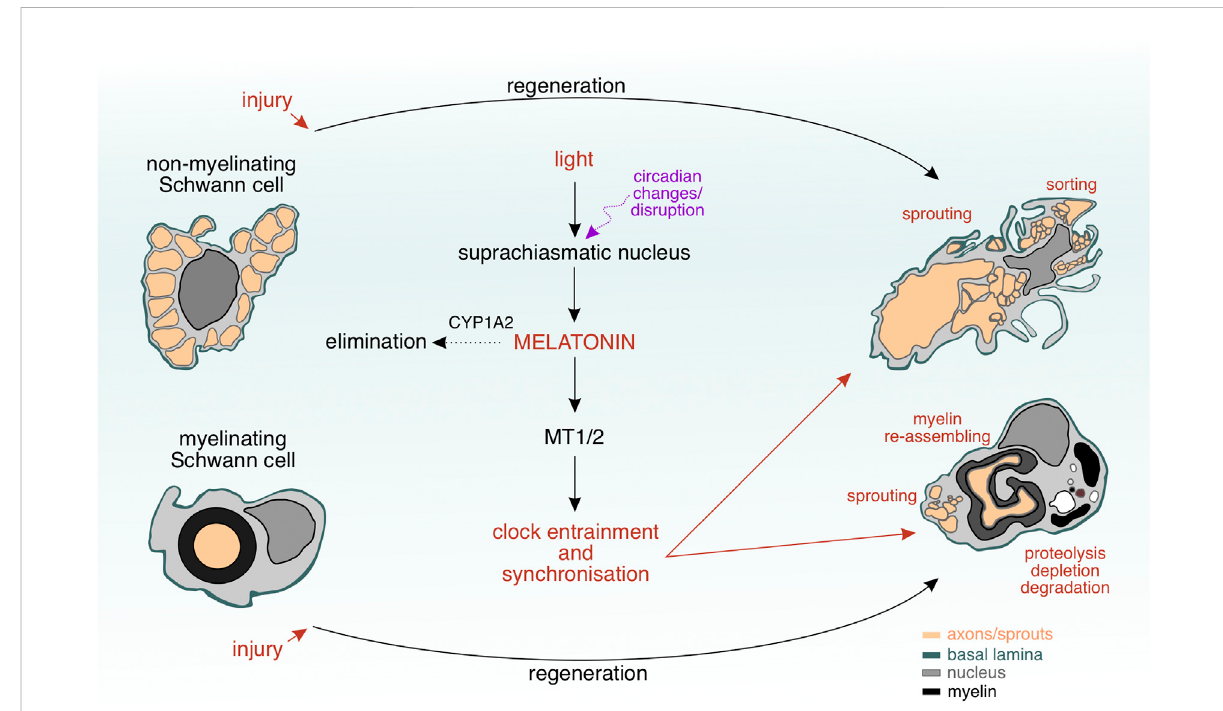
FIGURE 5 Interplay between Schwann cell plasticity and circadian clock during nerve regeneration. The Schwann cells undergo a remarkable transformation during nerve regeneration upon injury. Variations inlight ’ s intensity due to circadian changes ordisruption result inan altered activity of the suprachiasmatic nucles and melatonin concentration levels, to which the Schwann cells can respond selectively via their melatonin receptors (MT1/2). Degradation of melatonin by CYP1A2 or changes in blood – nerve barrier ’ s permeability are regulatory mechanisms allowing a certain amount of melatonin to penetrate the regenerating nervous tissue and to reach the Schwann cells within. MT1/2 may play a role as “ chronosensors ” to melatonin changes and induce internal clock changes, which allow the Schwann cells to unfold a complex morphology, where multiple events (sprouting, myelin re – assembling, proteolysis, depletion, degradation, and sorting) occur